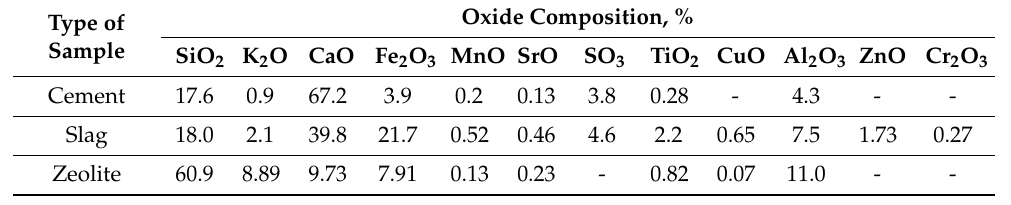
Table 1. Oxide composition of cement, slag and zeolite.